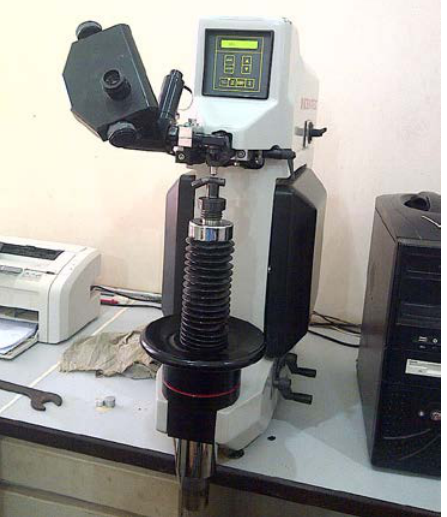
Figure 4: Indentec Tech Universal Testing Machine (Model Number, 900–331D, UNILORIN, NIG.)